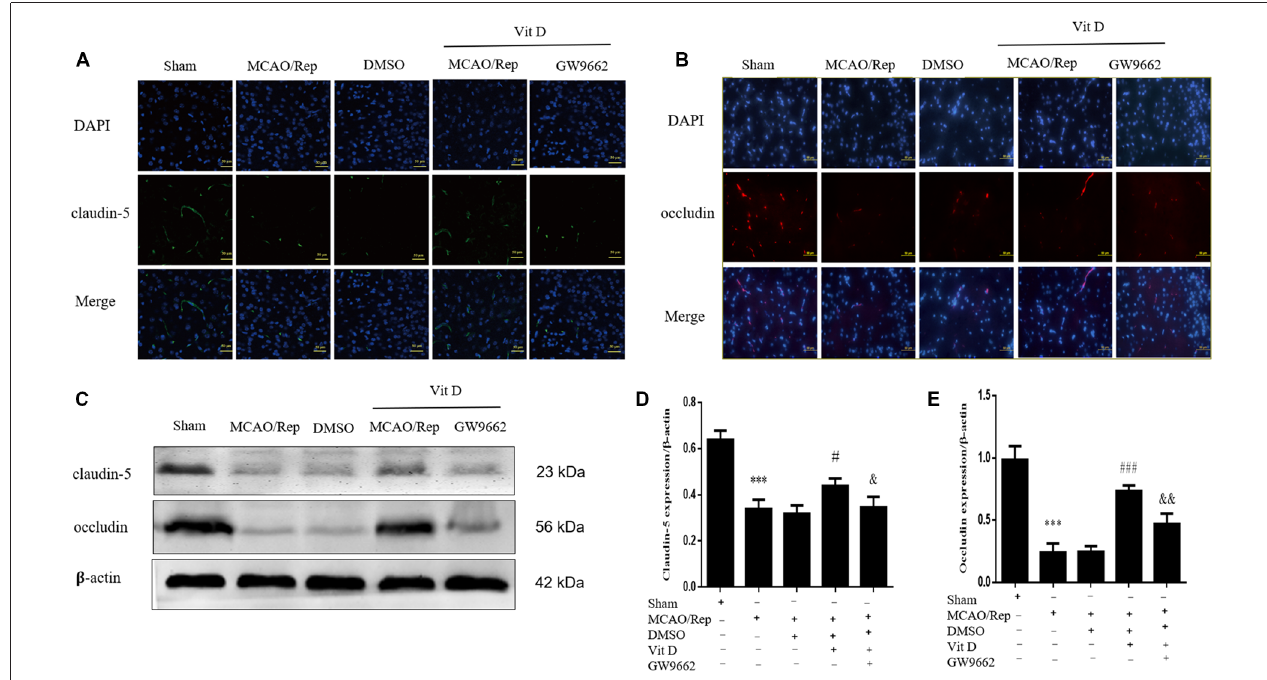
FIGURE 5 | 1, 25-D 3 (Vit D) protected against tight junction (TJ) degradation induced by cerebral ischemic reperfusion 24 h after MCAO. (A,B) In situ expression of claudin-5 (green), occludin (red) and 4 (cid:48) ,6-diamidino-2-phenylindole (DAPI; blue) in the peri-infarct region of sham-operated, MCAO/R, DMSO, 1, 25-D 3 and GW9662 groups (400 × magnification 400). (C–E) Western blots showing the expression levels of occludin and claudin-5 in the ischemic cortical tissue. Data are represented as Mean ± SEM, n = 6, ∗∗∗ P < 0.001 vs. sham group, ### P < 0.001 vs. DMSO group, # P < 0.05 vs. DMSO group, && P < 0.01 vs. 1, 25-D 3 group. & P < 0.05 vs. 1, 25-D 3 group. MCAO/R, middle cerebral artery occlusion/reperfusion; 1, 25-D 3 , 1, 25-dihydroxyvitamin D 3 ; DMSO, dimethyl sulfoxide; PPAR- γ , peroxisome proliferator-activated receptor-gamma; GW9662, inhibitor of PPAR- γ